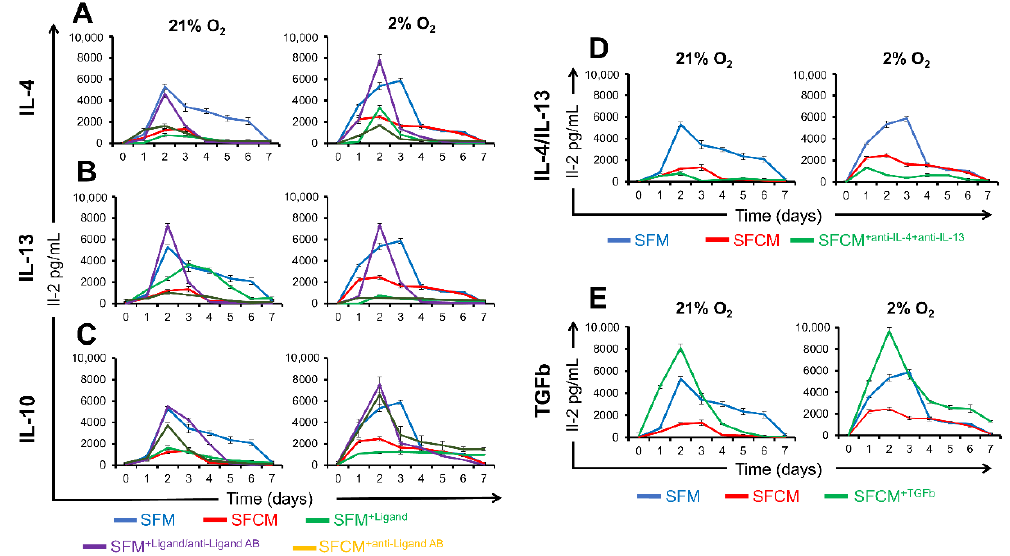
Figure 7. IL-10-devoid SFCM restores IL-2 secretion in activated Jurkat T cells. ELISA-based IL-2 detection (pg/mL) of Jurkat T cell culture media following in vitro activation over 7-days. PMA/PHA activated Jurkat T cells were cultured in different conditions consisting of SFM, SFCM, SFM +Ligand , SFM +Ligand/antiLigand AB , and SFCM +antiLigand AB in both air (21% O 2 ) and physoxia (2% O 2 ) oxygen environments. ( A ) IL-4 studies, ( B ) IL-13 studies, and ( C ) IL-10 studies. ( D ) ELISA-based IL-2 detection assay for the media of activated Jurkat cells cultured in SFM, SFCM, and SFM +antiIL − 4/antiIL − 13 in both air and physoxia oxygen tensions. ( E ) ELISA-based IL-2 detection assay for the media of activated Jurkat cells cultured in SFM, SFCM, SFCM +TGFb . Data expressed as mean ± SD; each result represents a replicate of 3 independent experiments ( n = 3).